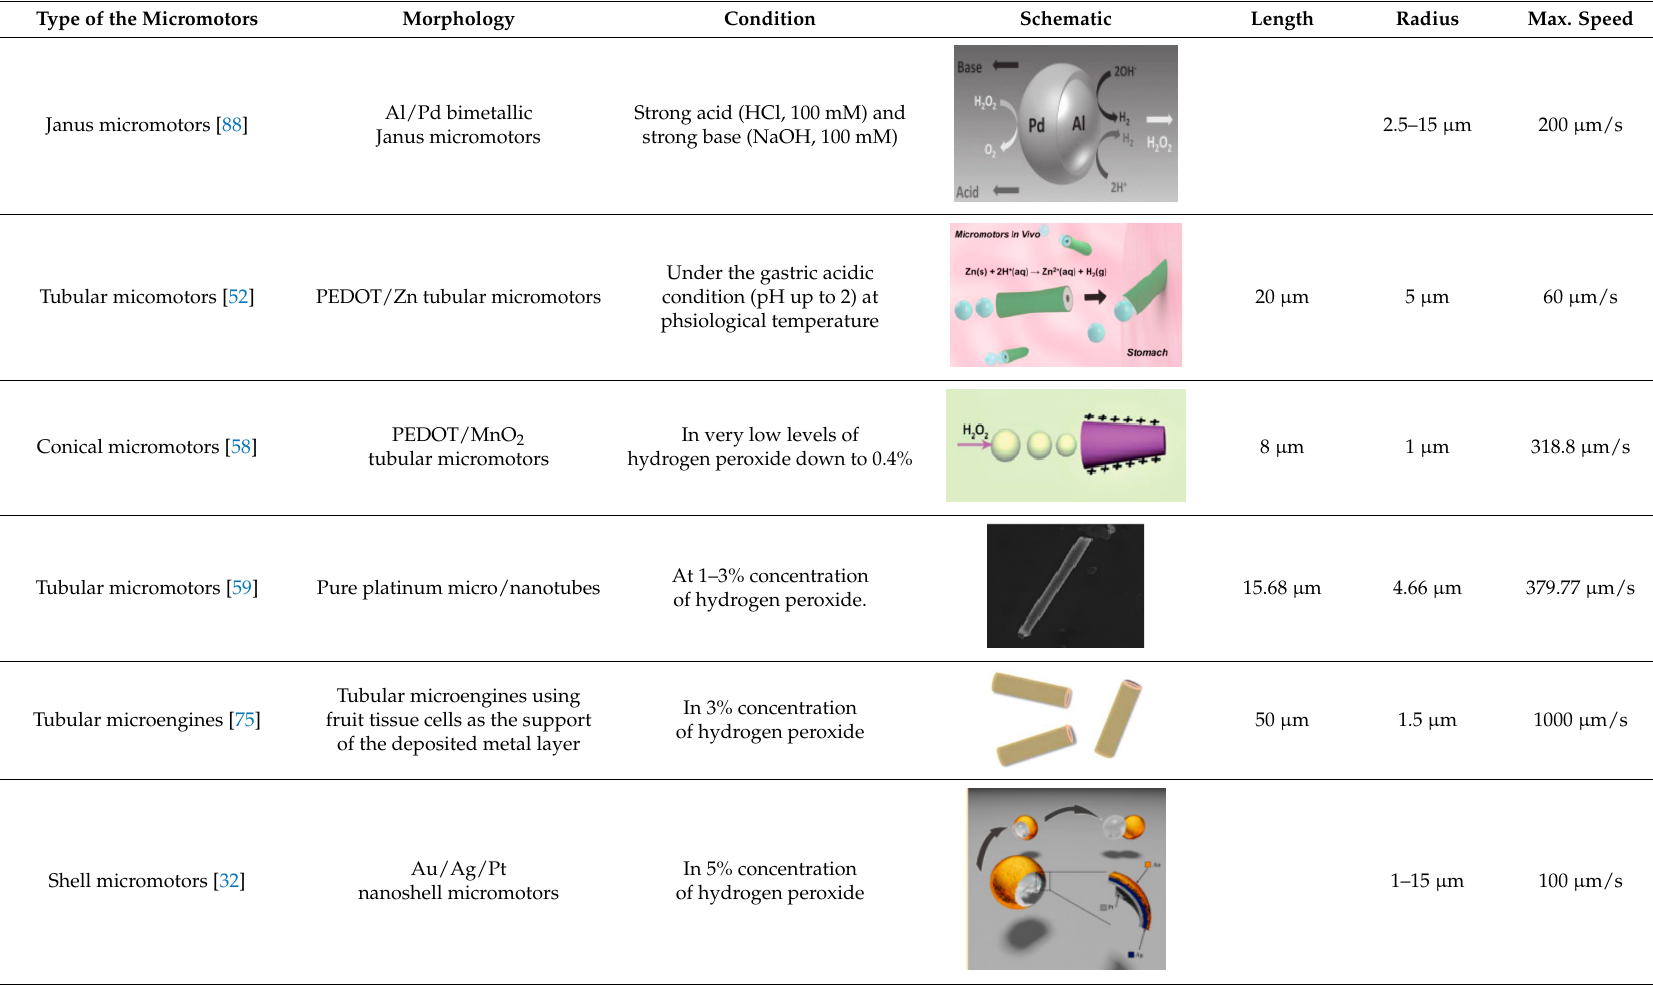
Table 1. Speed of bubble-driven microomtors. Reproduced with permission from [32,52,54,58,59,64,75,88–91].